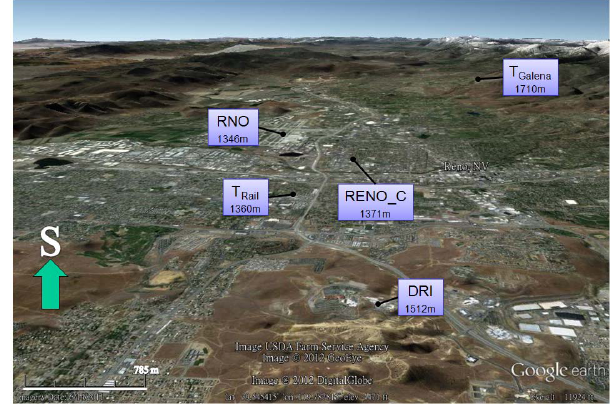
Fig. 1. Topography of the Truckee Meadows valley and loca- tions/elevations of PM 2 . 5 monitoring site (RENO C), valley-floor weather station (Reno Rail Yard, T Rail ) , elevated weather station (Galena, T Galena ) , Reno-Tahoe International Airport (RNO), and the Desert Research Institute